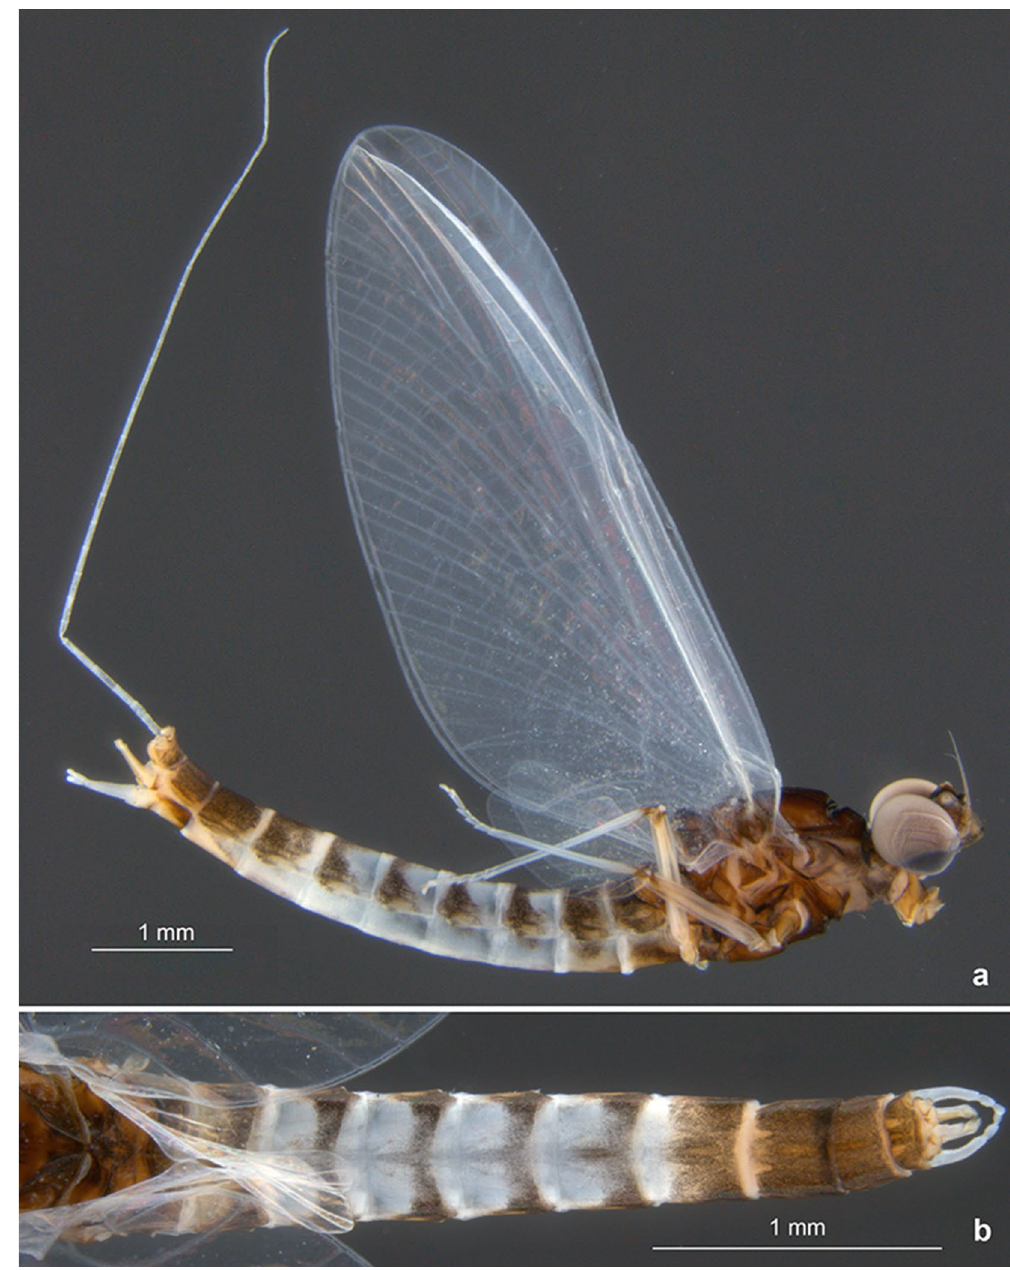
Figure 6. Calliarcys van Godunko & Bauernfeind, 2015 , male imago, paratype [Turkey; Soldán T. & Bojková J. coll.]: ( a ) body in right lateral view; ( b ) abdomen in dorsal